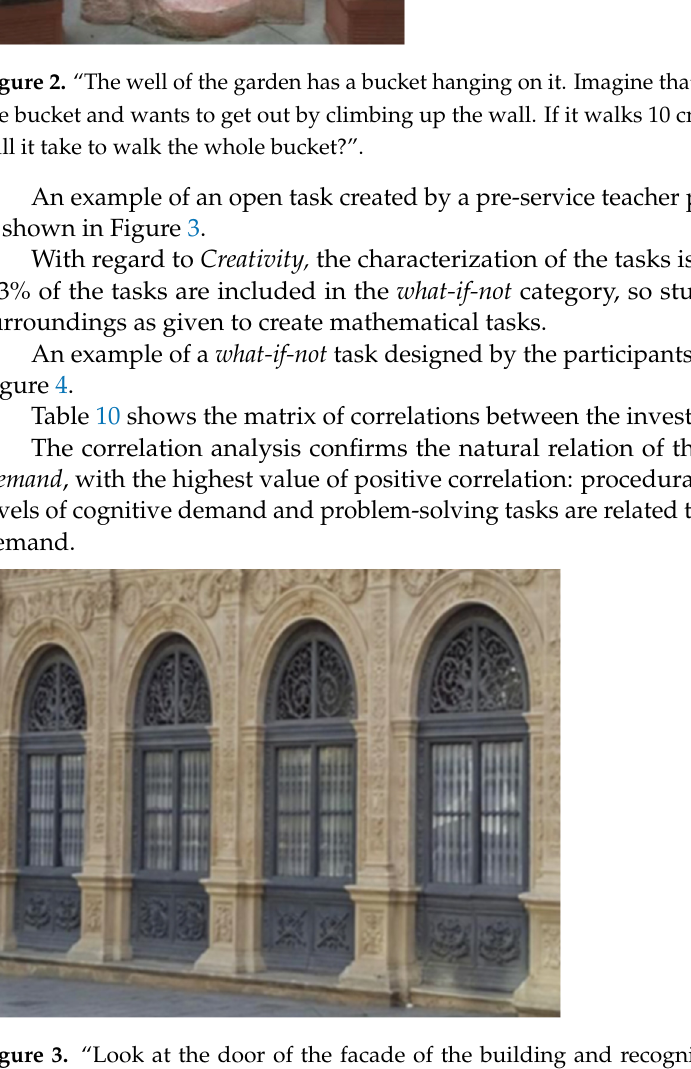
Figure 3. “Look at the door of the facade of the building and recognize the geometrical figures that appear on it. Can you think of a different way of dividing the door with different geometrical figures?”.